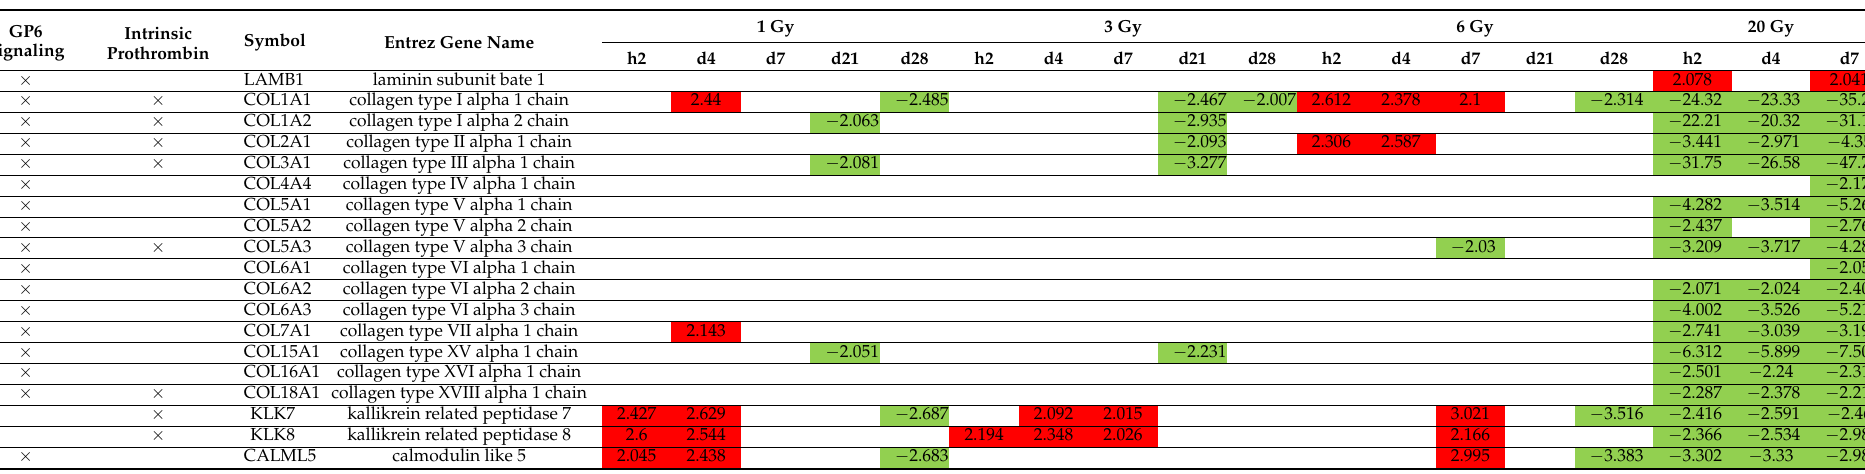
Table 1. Significantly differentially transcribed genes underlying the identification of GP6 signaling and intrinsic prothrombin signaling pathways. These